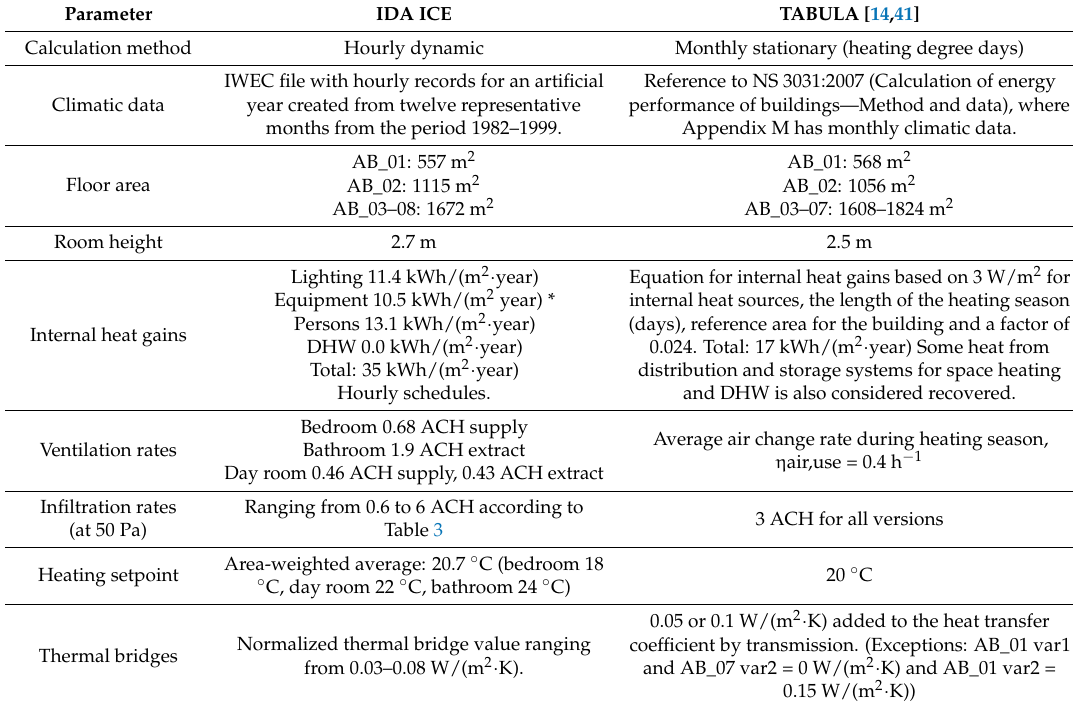
Table A1. Differences between methods and input data for IDA ICE and